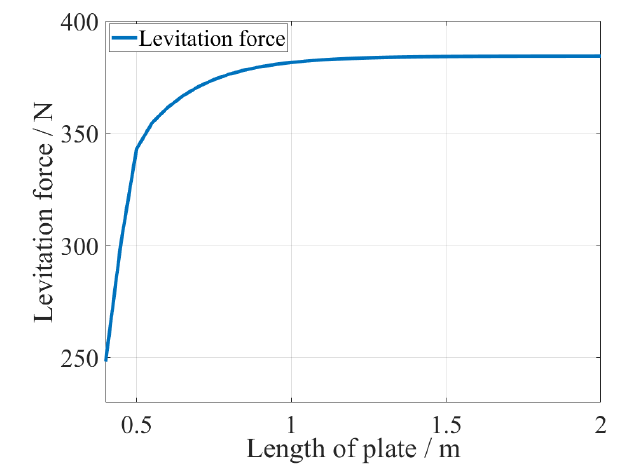
Figure 9. Variation in levitation force to the length of the conductive plate.